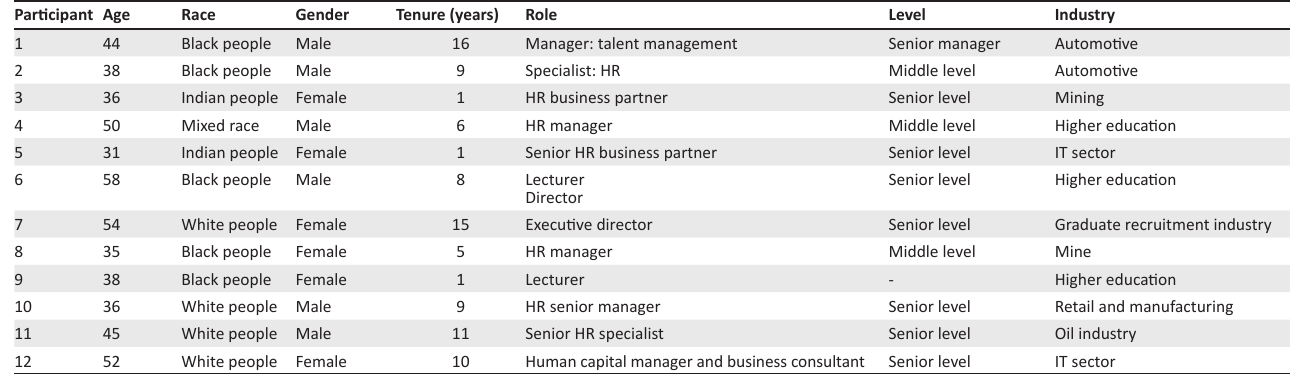
TABLE 1: Participant